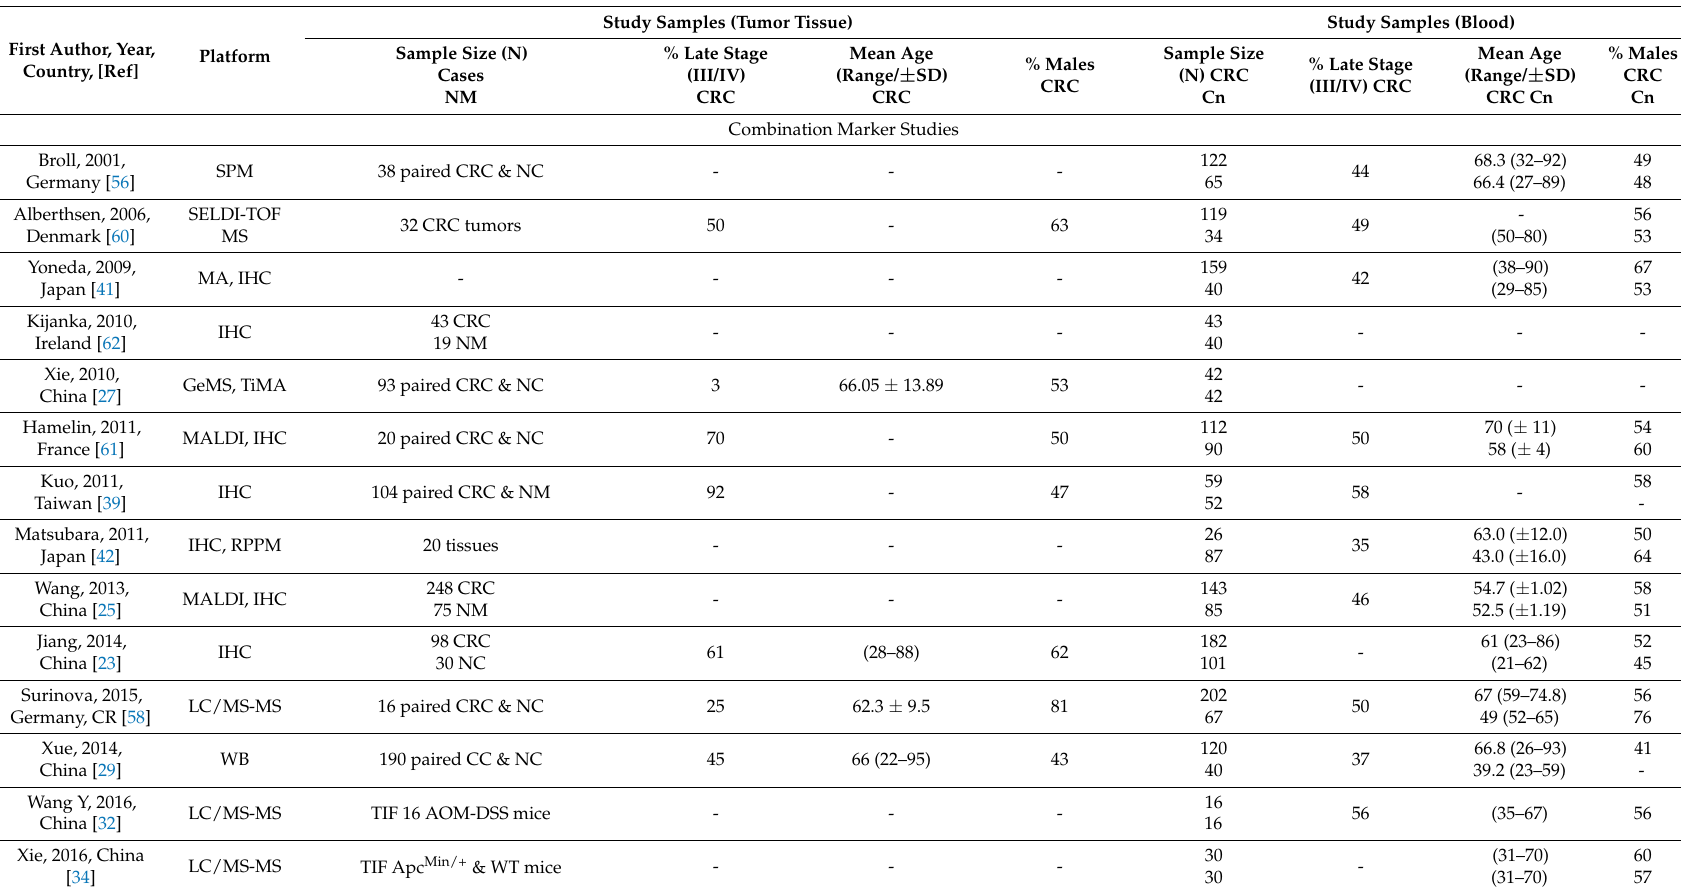
Table 2. Patient characteristics of the tumor tissue proteome/TIF